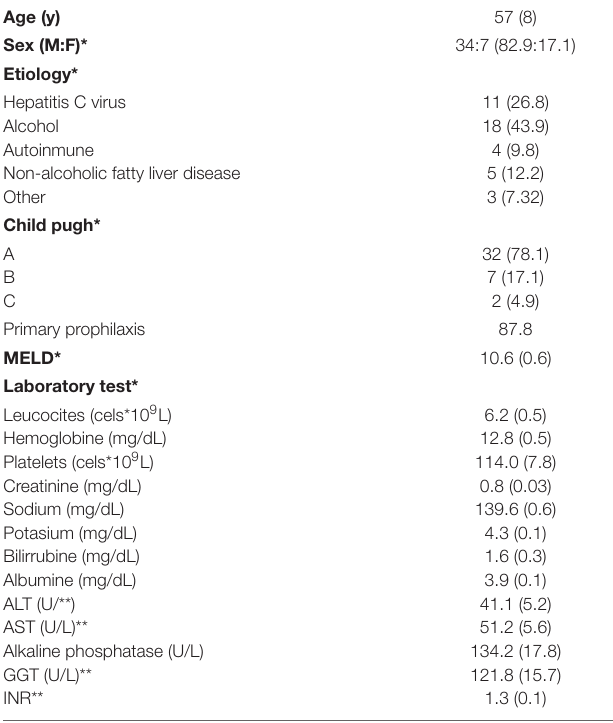
TABLE 1 | Baseline characteristics of the